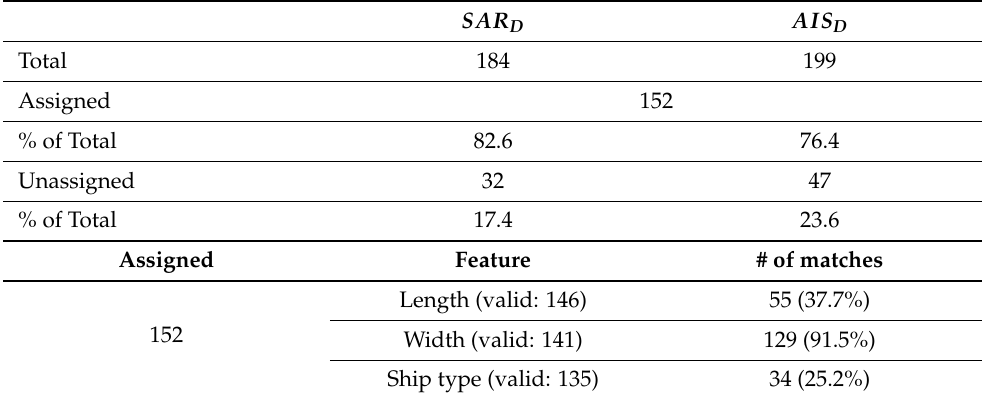
Table 7. English Channel total number of (top) assignments and unassignments (bottom) features in